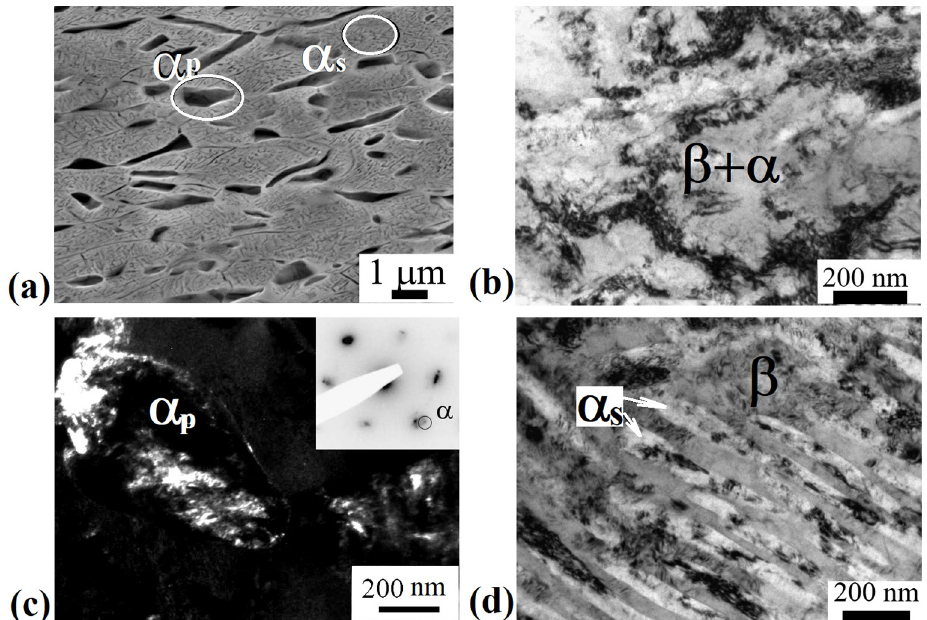
Figure 3. Microstructure of the Ti-15Mo alloy after ECAP-C, longitudinal section: ( a ) SEM image; ( b ) dislocation cells, TEM; ( c ) dark-field image of the primary α p phase, TEM; ( d ) bright-field image of secondary α s -phase particles, TEM.